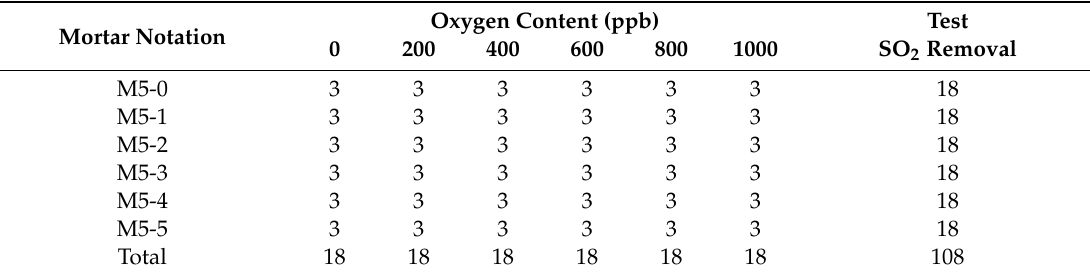
Table 4. Experimental